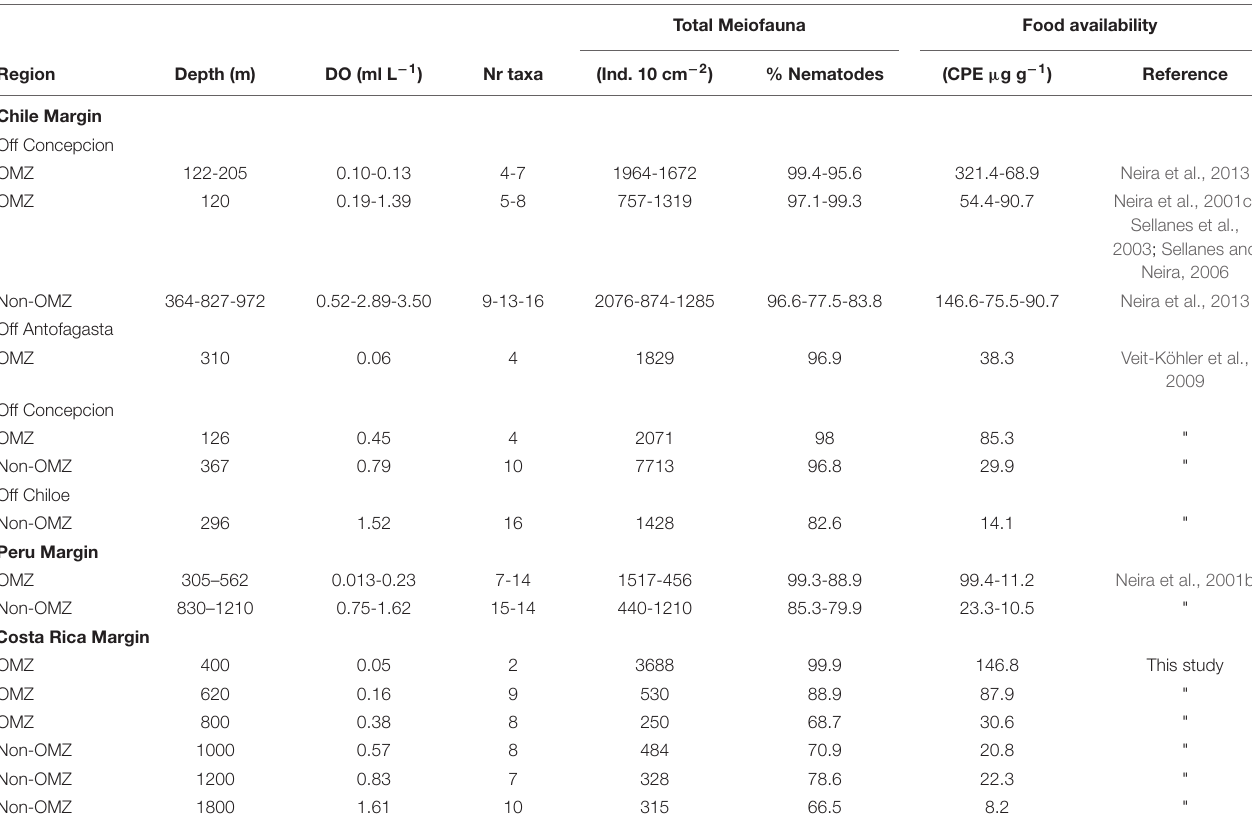
TABLE 5 | Comparison of meiofaunal densities, number of meiofaunal taxa present, relative abundance of nematodes in and outside the OMZ along the eastern Pacific margin (range depths: 120–1800 m) in relation to bottom-water DO and CPE as food availability. Total Meiofauna Food